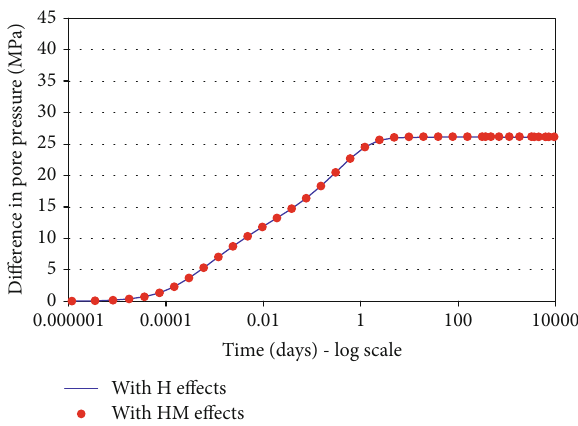
Figure 8: Variation with time of the di ff erence in the fl uid pore pressure between the injection and production boreholes obtained with consideration of hydrological (H) and hydromechanical (HM) e ff ects.